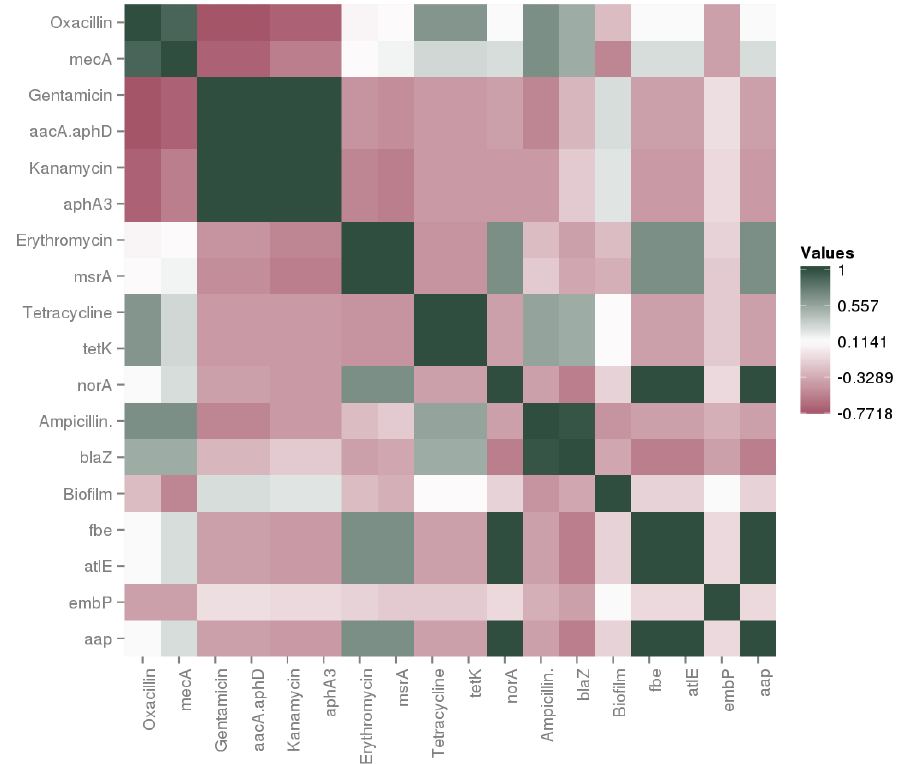
Figure 3. Correlation matrix of phenotypic and genotypic features regarding antibiotic resistance and bioflm formation ability.